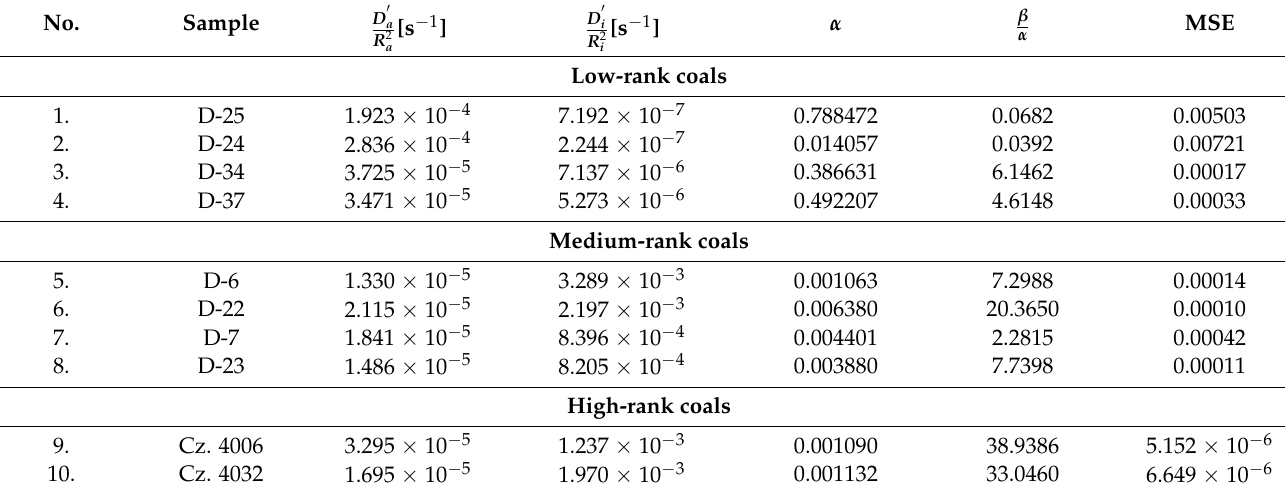
Table 4. The bidisperse diffusion model fitting parameters for the methane adsorption rate data at pressure 0.1 MPa. No.